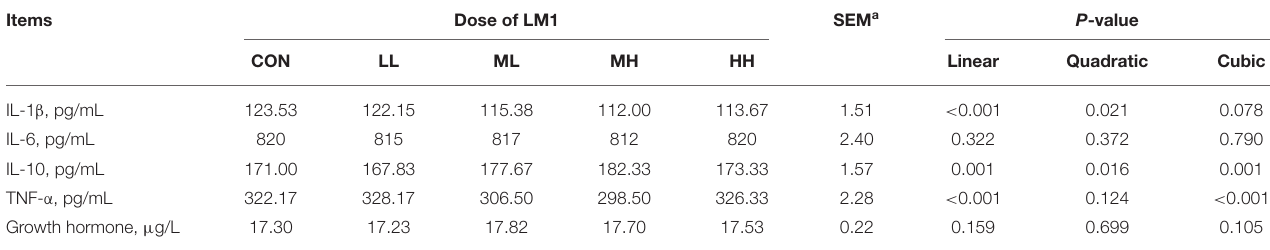
TABLE 4 | Effects of dietary LM1 on serum cytokines of growing